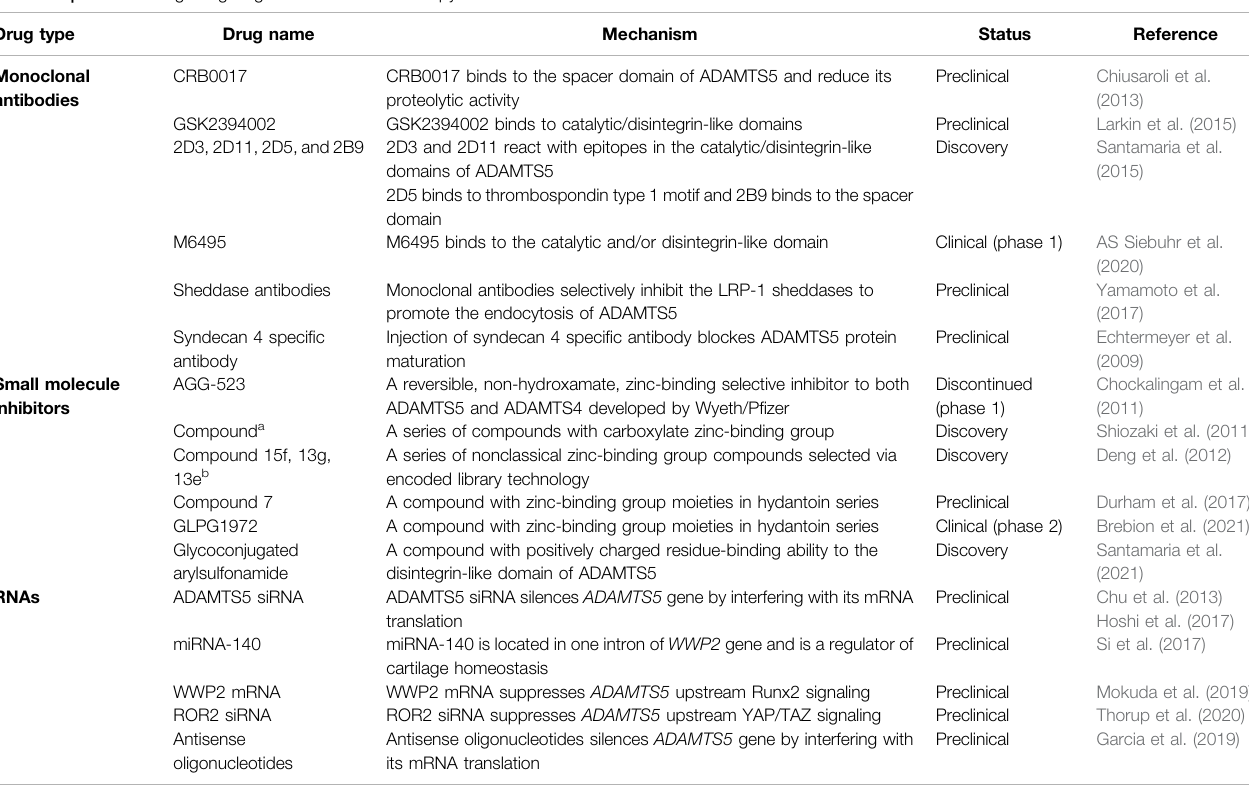
TABLE 2 | Potential drugs targeting ADAMTS5 in OA